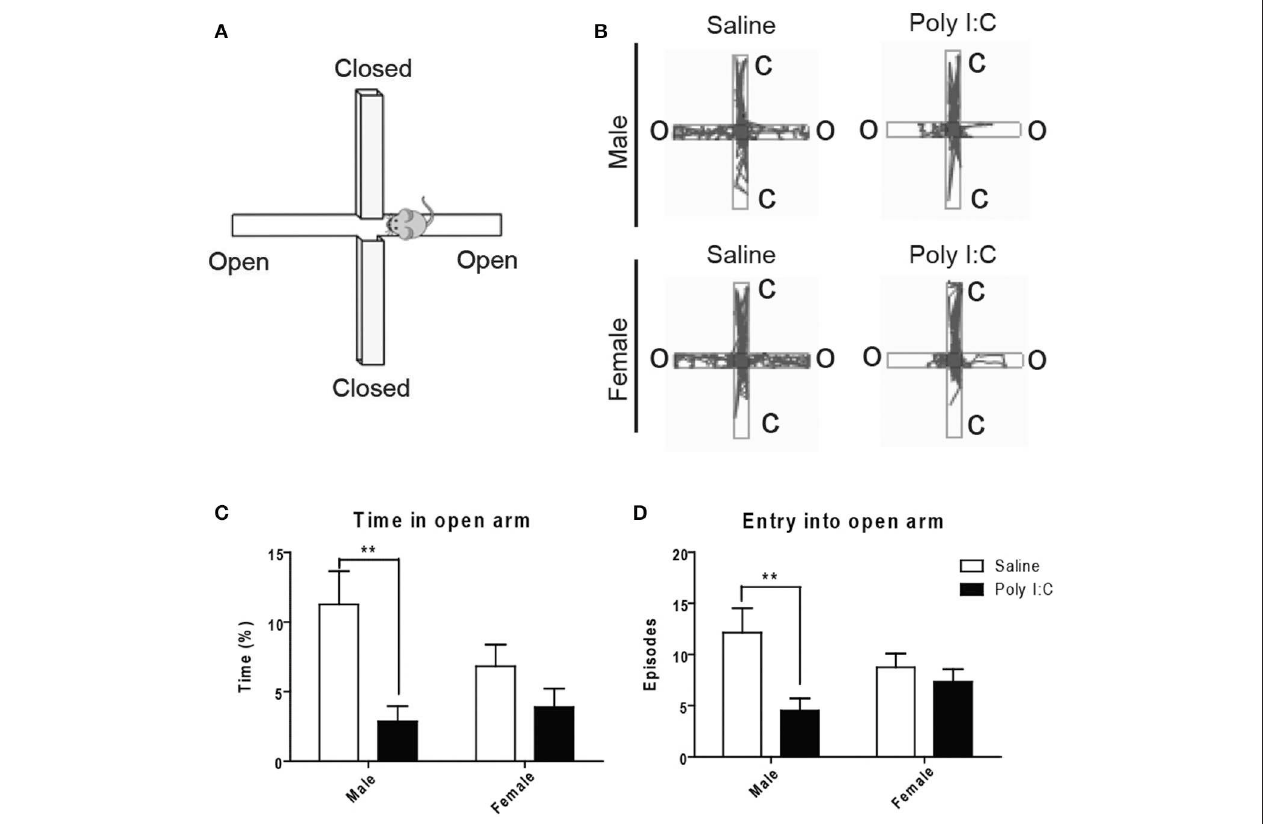
FIGURE 4 | Effects of Poly I:C on anxiety-like behavior measured in the elevated plus maze. (A) Orientation of the elevated plus maze platform. (B) Representative motion plots in males and females from saline and Poly I:C injection groups. (C,D) Anxiety level was determined by measuring the time spent and number of entries in the open arm during testing. n = 6–8 mice per sex and group. C, closed arm; O, open arm. ** p <